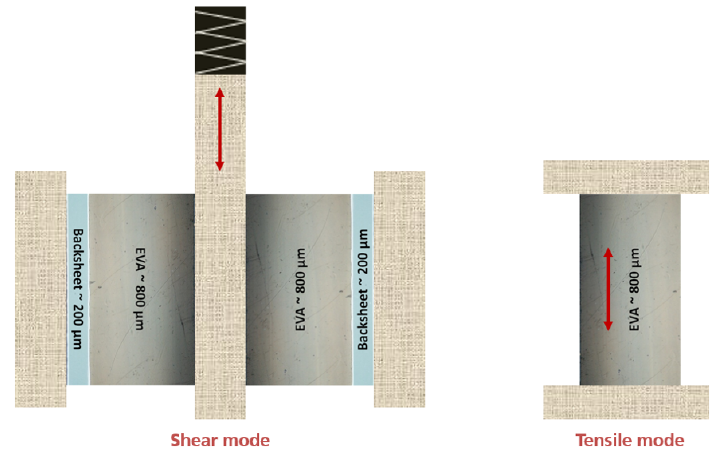
Figure 9. Schematic experimental setup DMA. The arrows represent the direction of the force excitation during measurement.